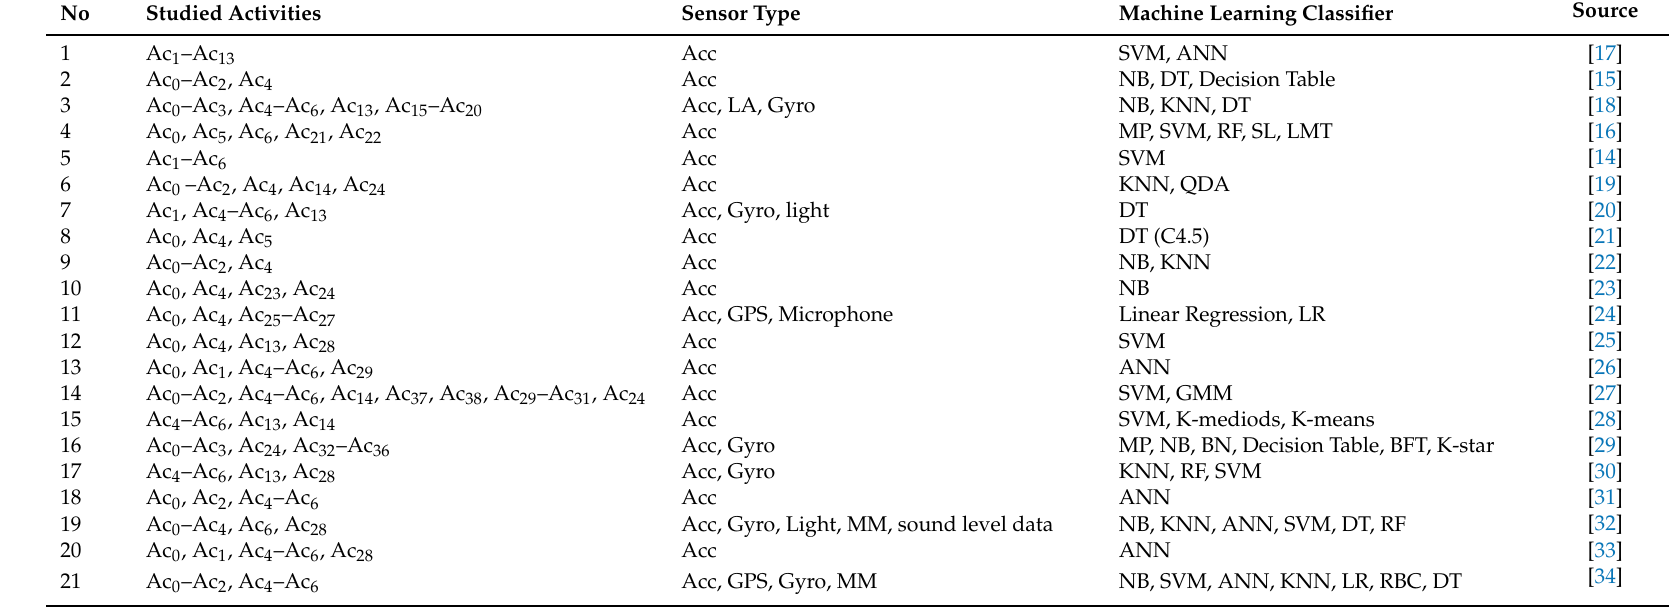
Table 1. Studies on recognized activities using an Android mobile